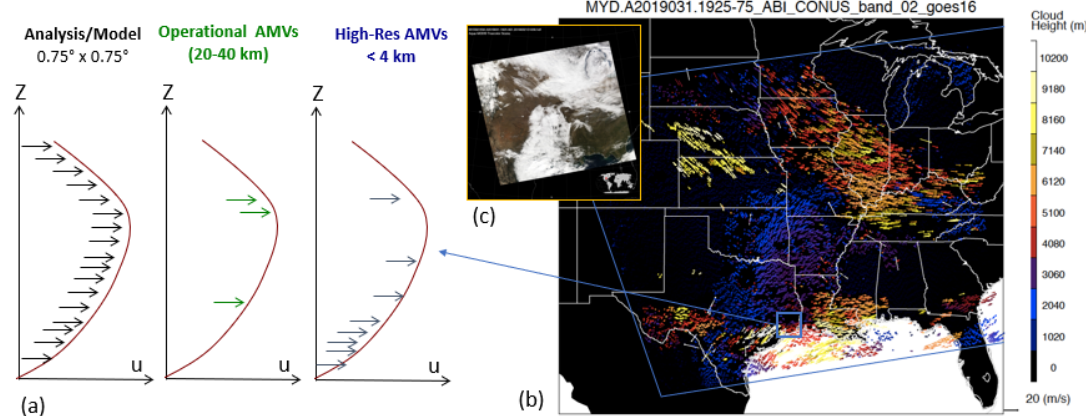
Figure 24. ( a ) Illustration of the improvement from high-resolution ( < 4 km) AMVs in representing a quasi-3D synoptic flow. Compared to conventional AMV retrievals at a coarser resolution, the high-resolution algorithm provides more vertical levels of AMVs that can be assimilated in the NWP system. ( b ) AMVs at 2 km horizontal resolution from the MODIS-GOES retrieval on January 31, 2019 when a cold Arctic system dipped down to CONUS and created severe winter storms in most of the northern states ( c ). The height of wind vectors is color coded and shows a range of AMV heights from the surface to ~11 km. The blue lines indicate the borders of MODIS image granule in this case (as shown in the embedded image).